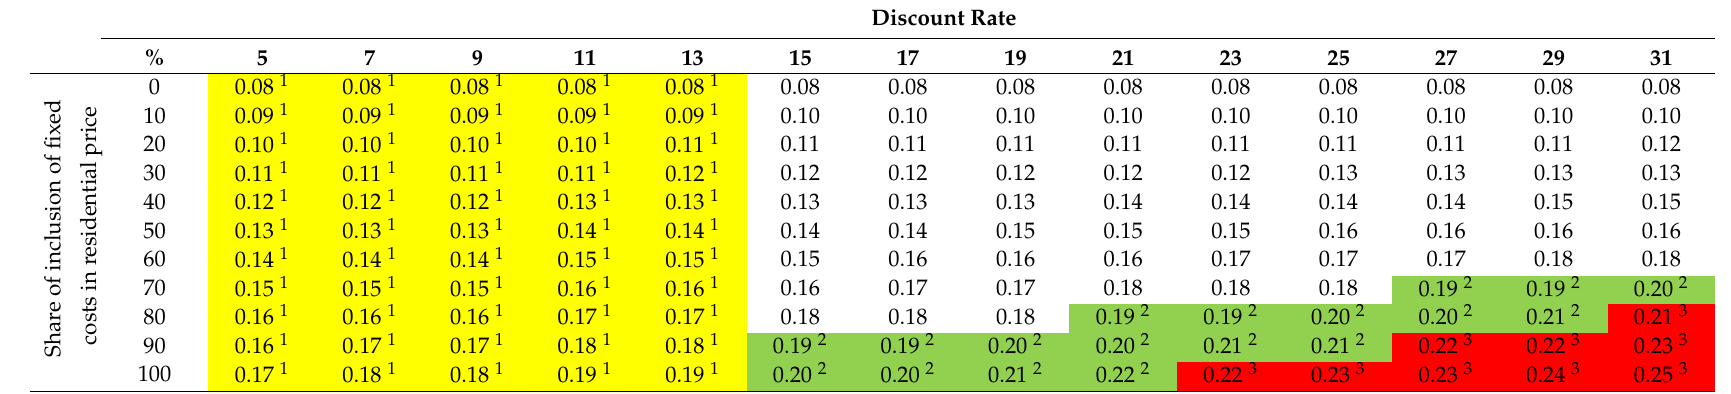
Table 4. Dependence of residential LCOE on discount rate and on share of inclusion of fixed costs in residential price in case two TS are installed.